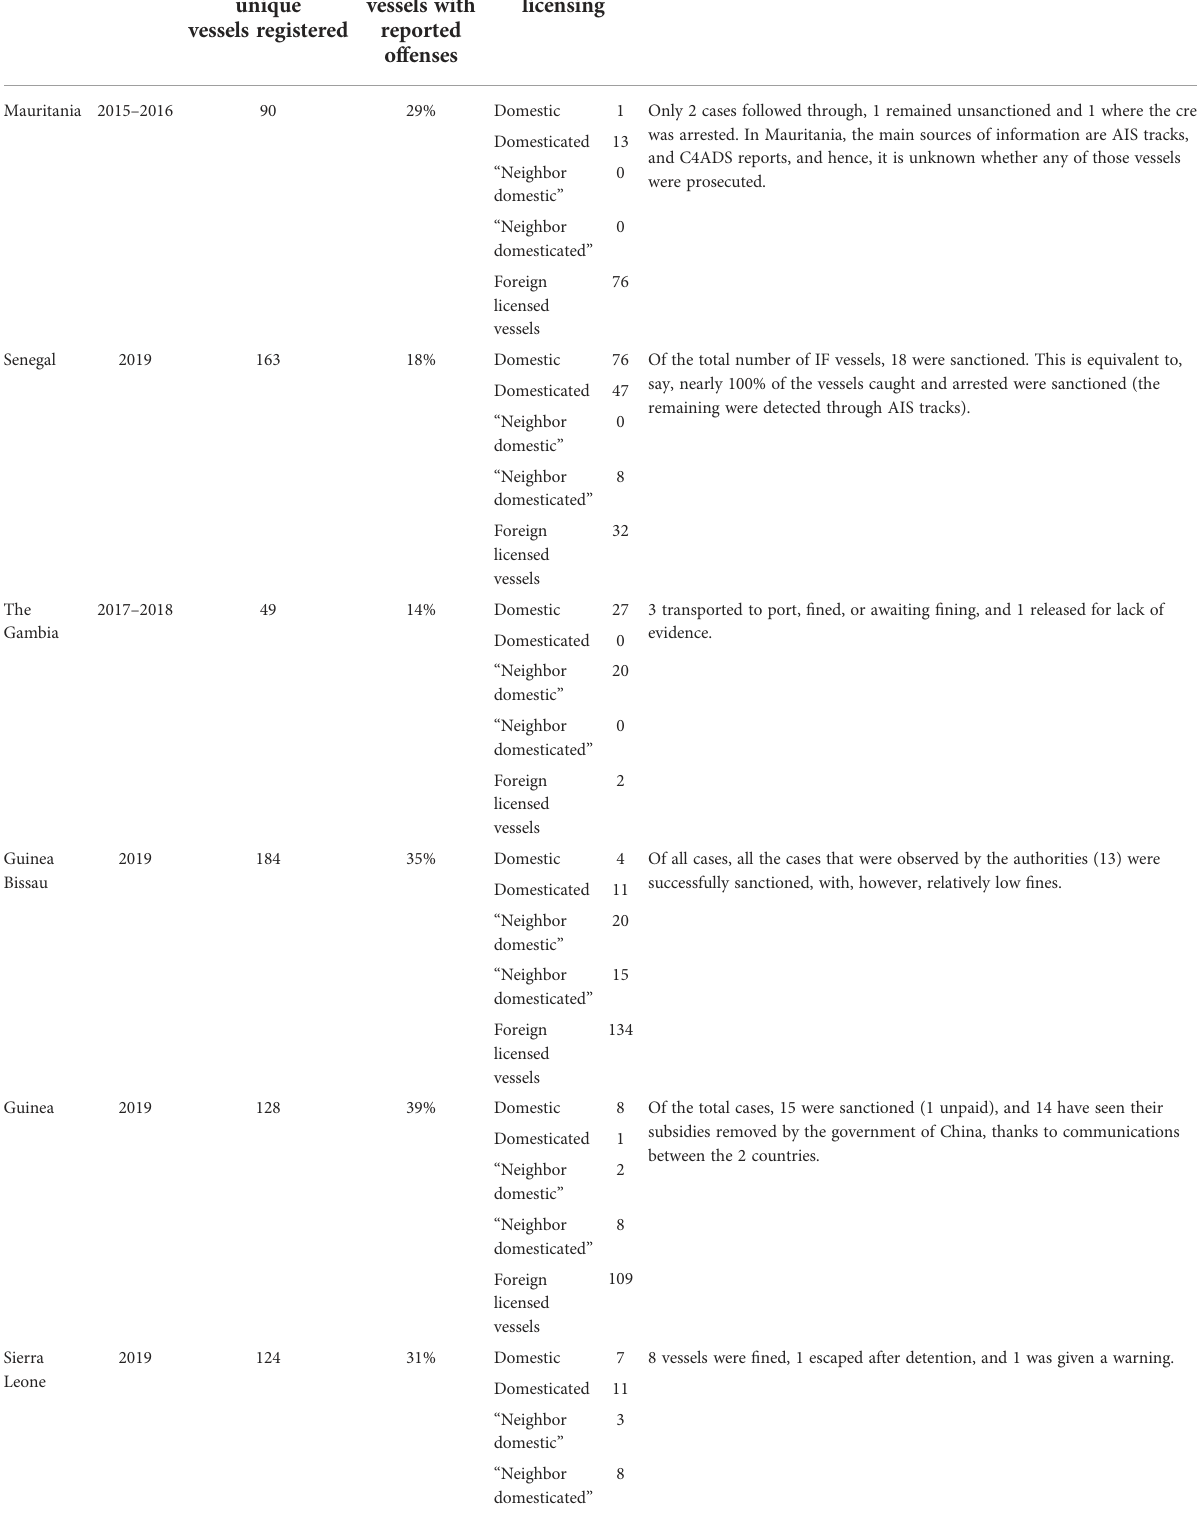
TABLE 2 Number of registered industrial fi shing vessels per country in West Africa.